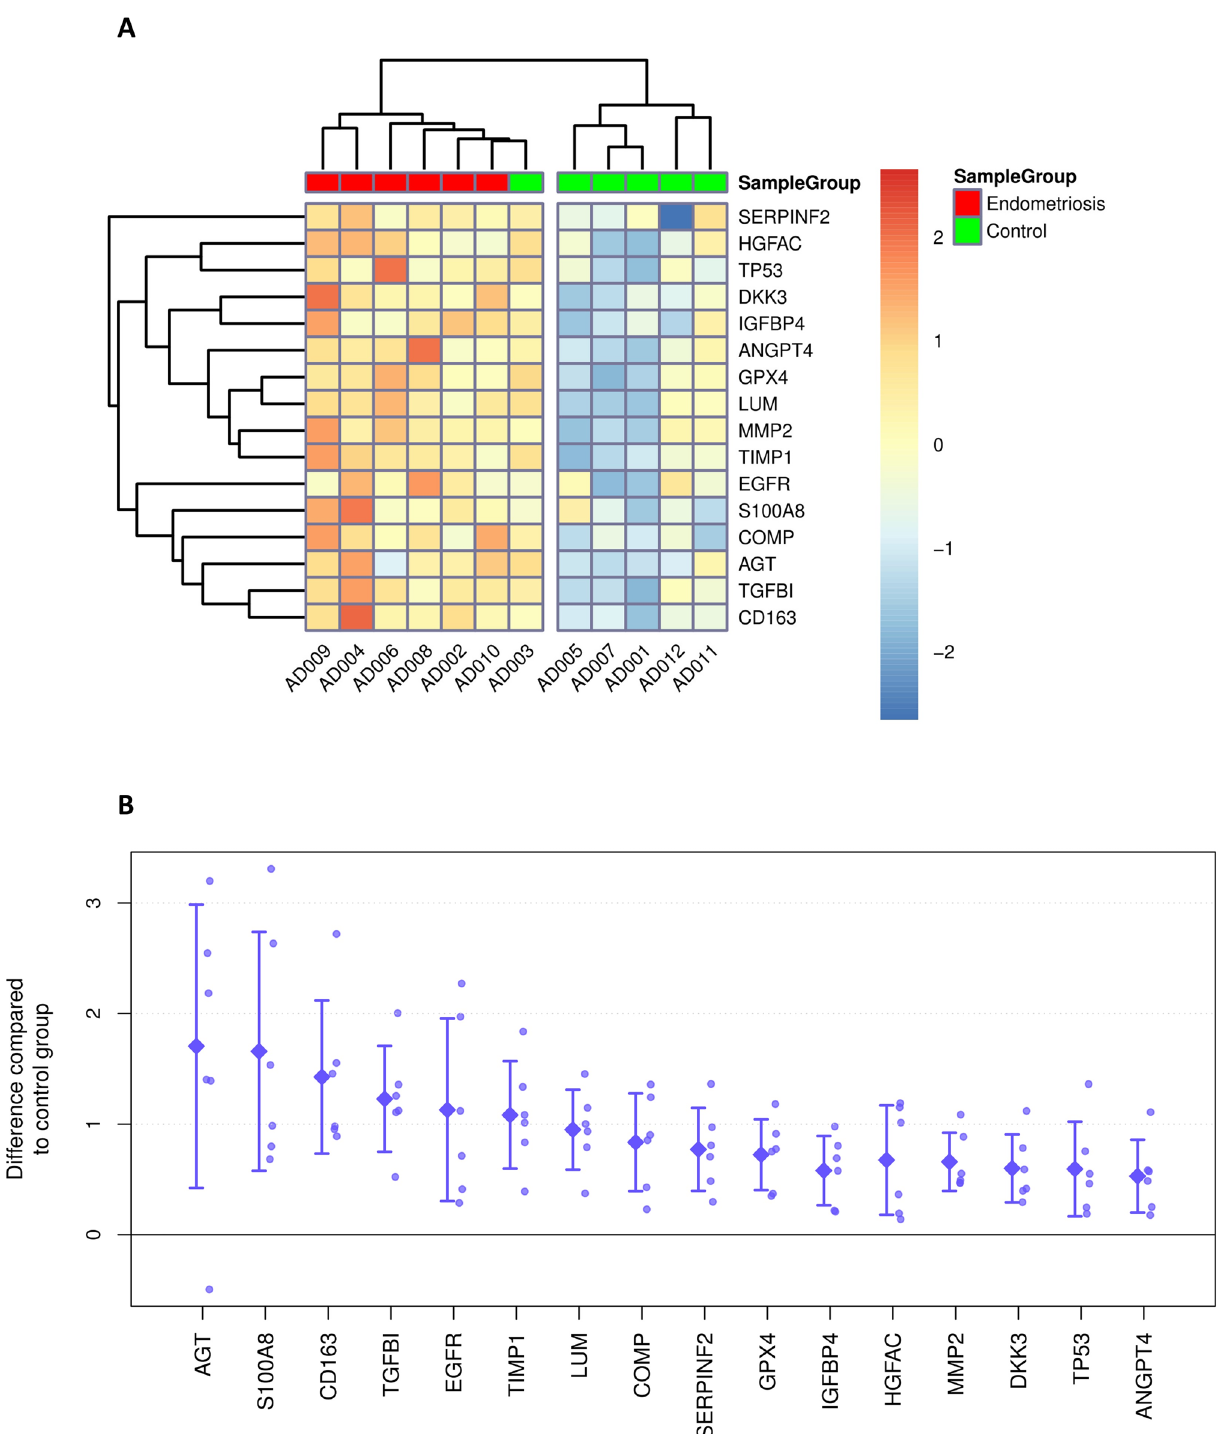
Figure 3. Heatmap displaying the relative expression of proteins identified as differential. Values were centered and scaled by proteins ( A ). Array value differences between individual endometriosis samples and the average of control samples for the selected differential proteins ( B ). Rhombs indicate sample group means. Whiskers indicate one standard